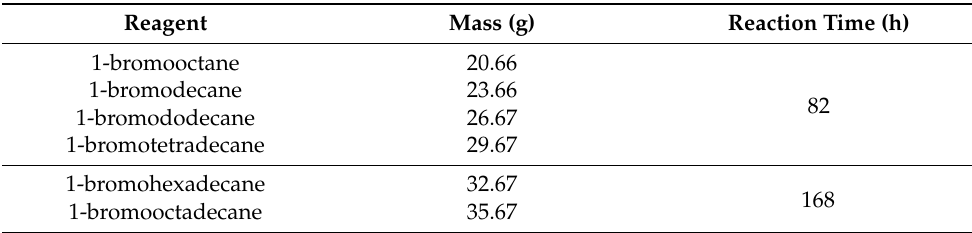
Table 3. Weights of alkyl bromides and reaction times in the N -alkylation stage (formation of QAHAMAs).